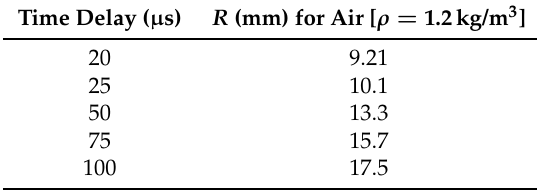
Table 2. Computed shockwave radii for standard ambient temperature and pressure (SATP) air, 200mJ